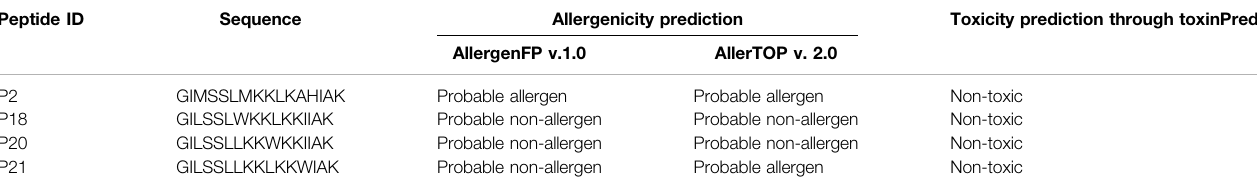
TABLE 4 | The allergenicity and toxicity pro fi ling of the best four-peptide molecules. Peptide